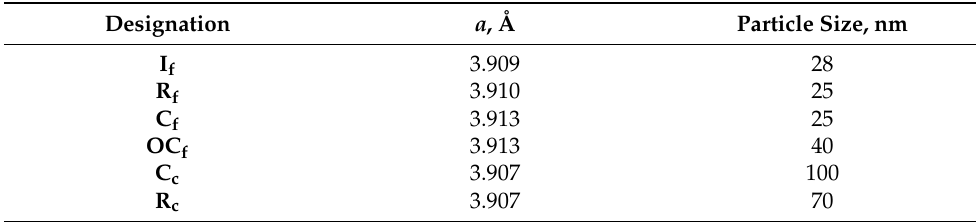
Table 2. Lattice constant a and particle size derived from XRD and SEM data.